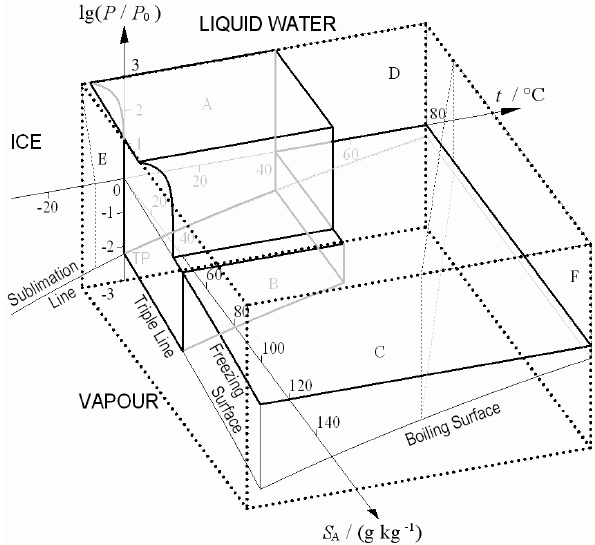
Fig. 5.3 Range of validity of the IAPWS-08 Gibbs function of seawater. Region A: oceanographic standard range, B: extension to higher salinities, C: extensions to higher temperature and salinity values at atmospheric pressure, D: zero-salinity limit, E: extrapolation into the metastable region, F: hot concentrates; at temperature and salinity values beyond the vertical plane indicated by dotted lines, results that are influenced by the pressure dependence of the Gibbs function are particularly uncertain. The cuboid indicated by heavy dotted lines represents the necessary conditions for validity used for range checking. (figure adapted from Fig. 3 of Part 1)